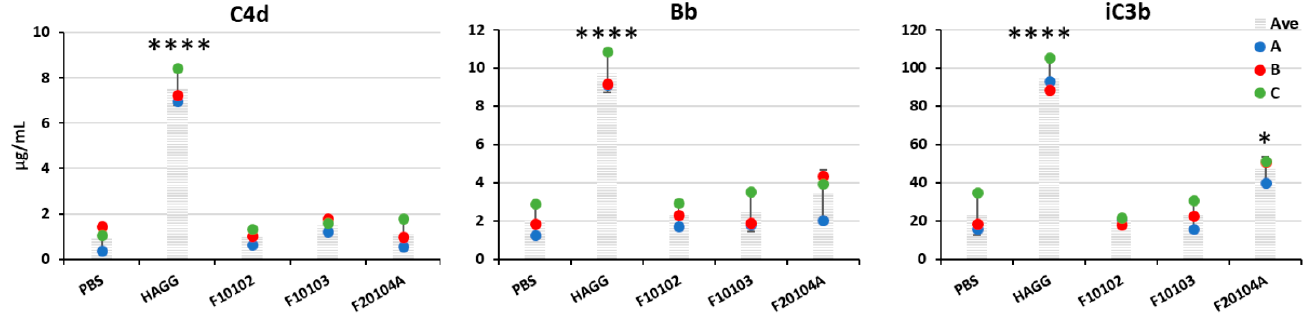
Figure 7. Levels of C4d (left), Bb (center), and iC3b (right) in the plasma of healthy volunteers upon incubation with liposomes. Fresh human plasma from three healthy donors was incubated with liposomes F10102, F10103, or F20104A at 150 µg/mL for 1 h at 37 °C. PBS and heat-aggregated gamma globulins (HAGG, 0.5 mg/mL) were used as negative and positive controls, respectively. Data are shown as individual values (dots of different colors for the three donors) and also as mean (shaded columns) ± SD. * p <0.05, **** p < 0.0001.